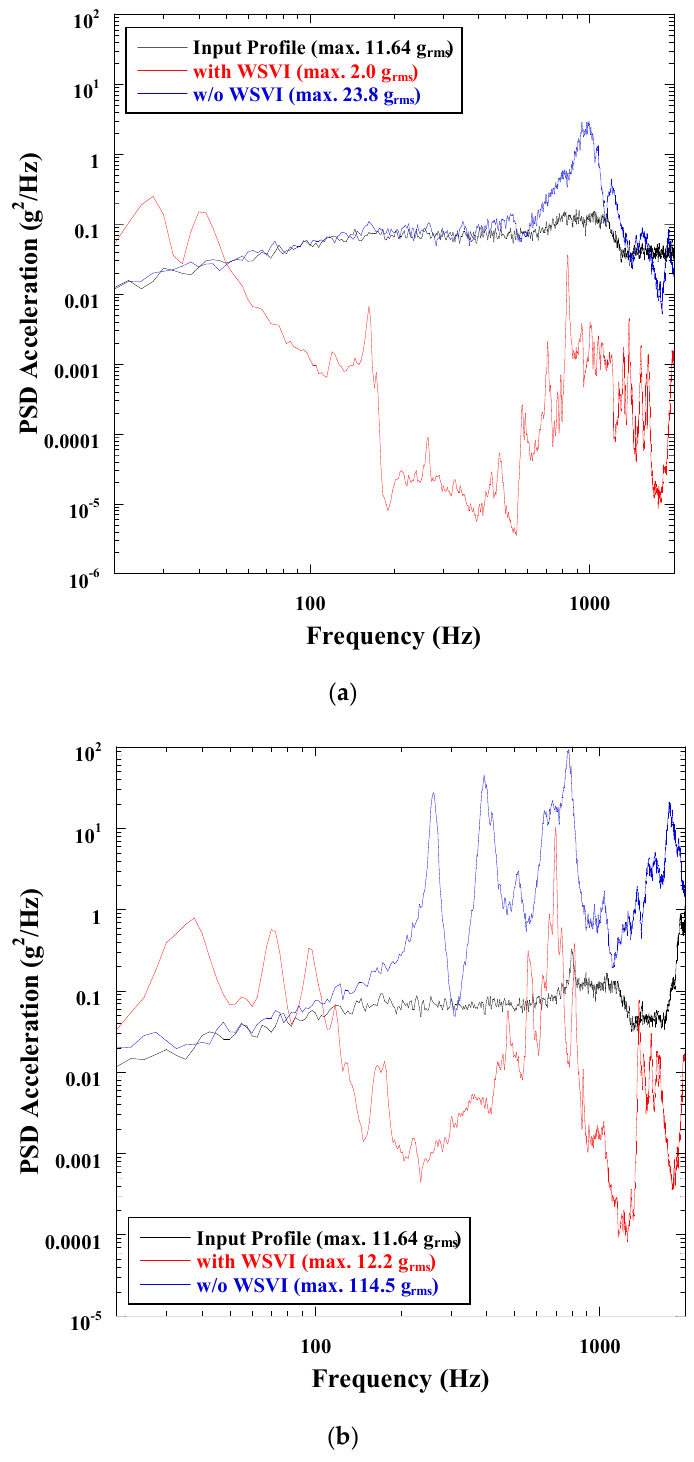
Figure 7. Random-Vibration Test Results (( a ) y- axis, ( b ) z- axis).